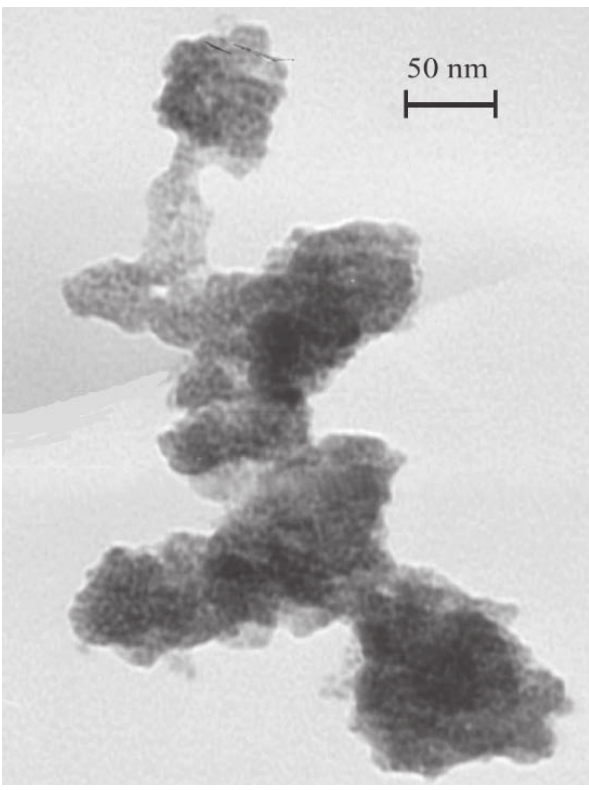
Fig. 5: TEM image of the HgSe in presence of SDS for 30 min (no. 2).